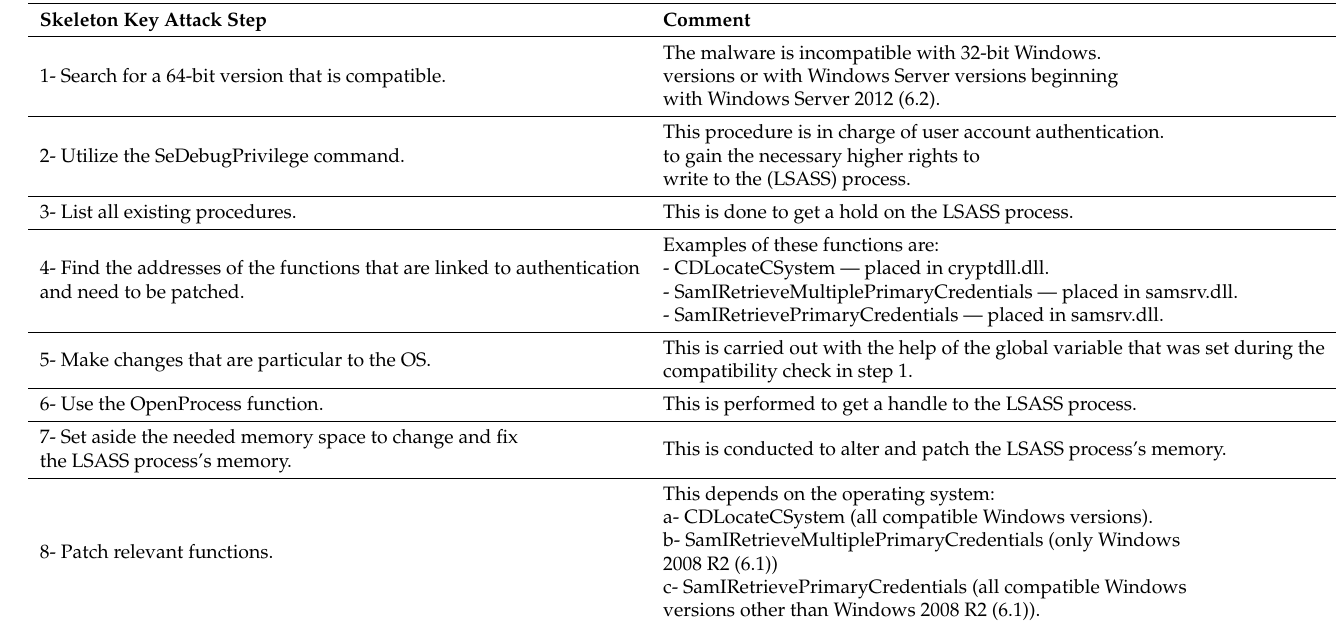
Table 2. Skeleton Key Attack